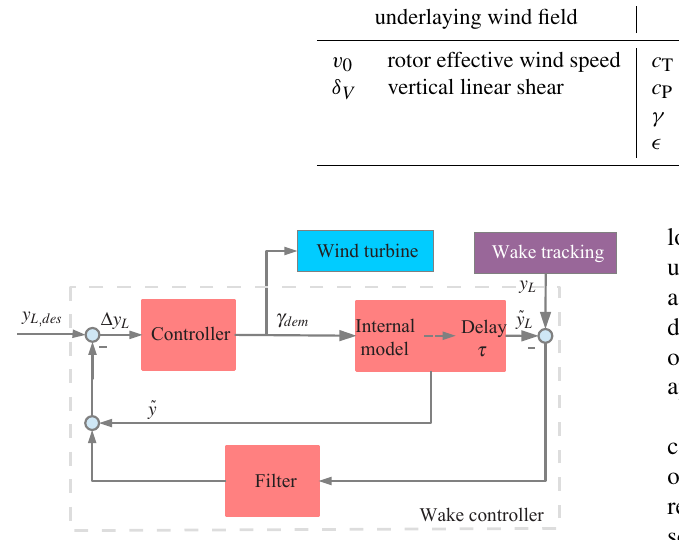
Figure 11. The general structure of the wake steering controller: the controller, a simplified wake model and the wake propagation modeled with a delay, and the filter. The controller uses the differ- ence δy L , between the predicted output e y , the measured output y L and the desired output y L, des to set the demanded yaw angle γ dem